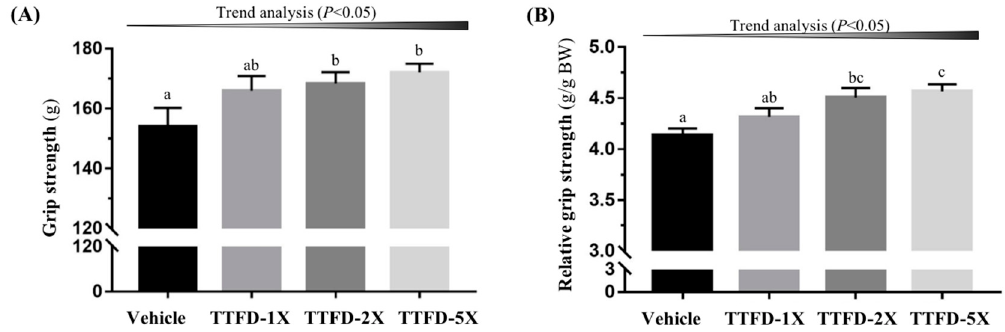
Figure 4. Effect of 4-week TTFD supplementation on absolute forelimb grip strength ( A ) and forelimb grip strength (%) relative to body weight ( B ). Data are mean ± SEM for n = 10 mice per group. Columns with different letters (a, b, c) are significantly different at P < 0.05.